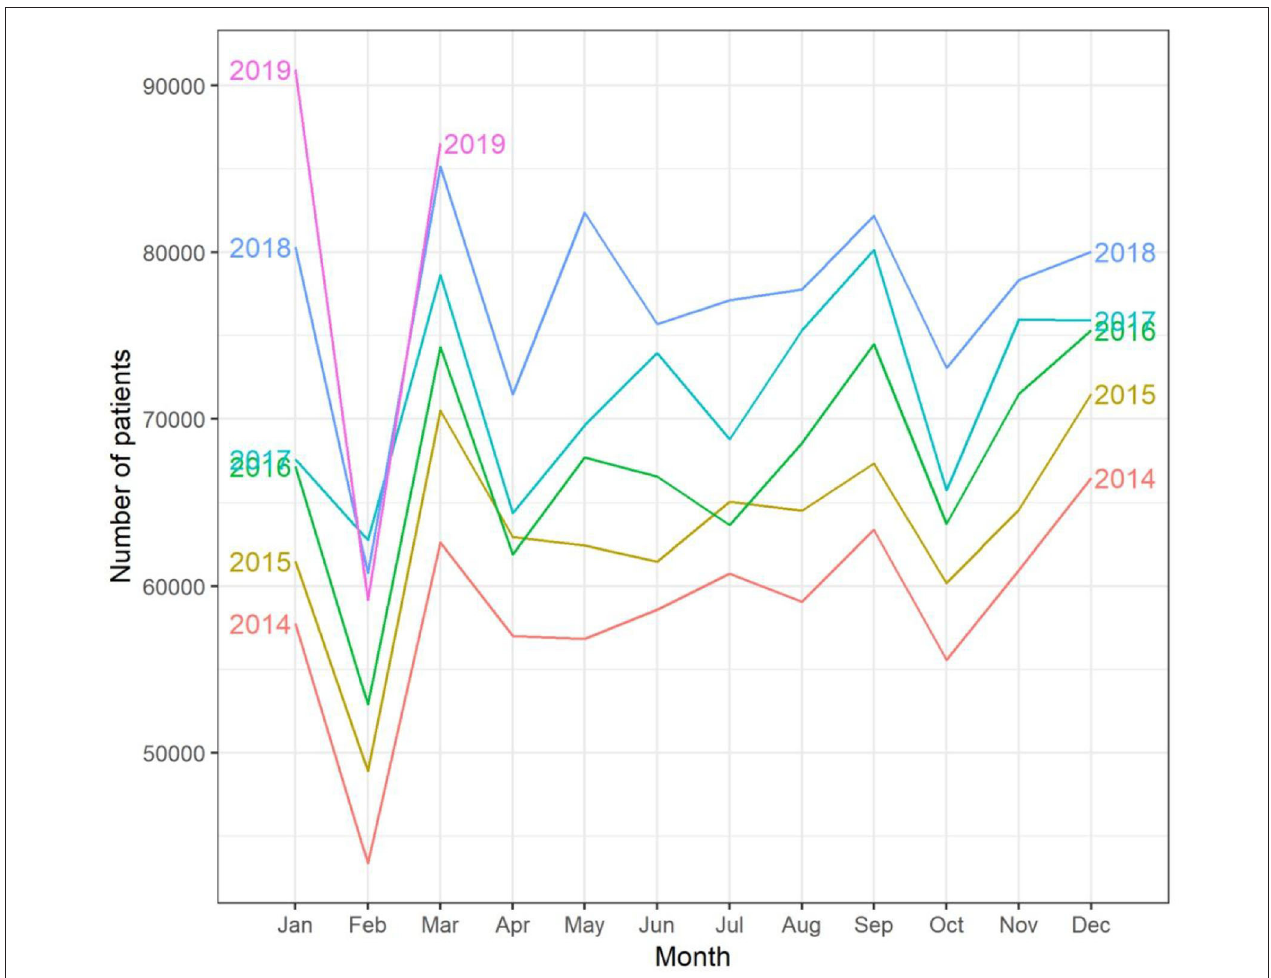
FIGURE 2 | Seasonal plot of total outpatients at the Shanghai Mental Health Center from January 2014 to March 2019.